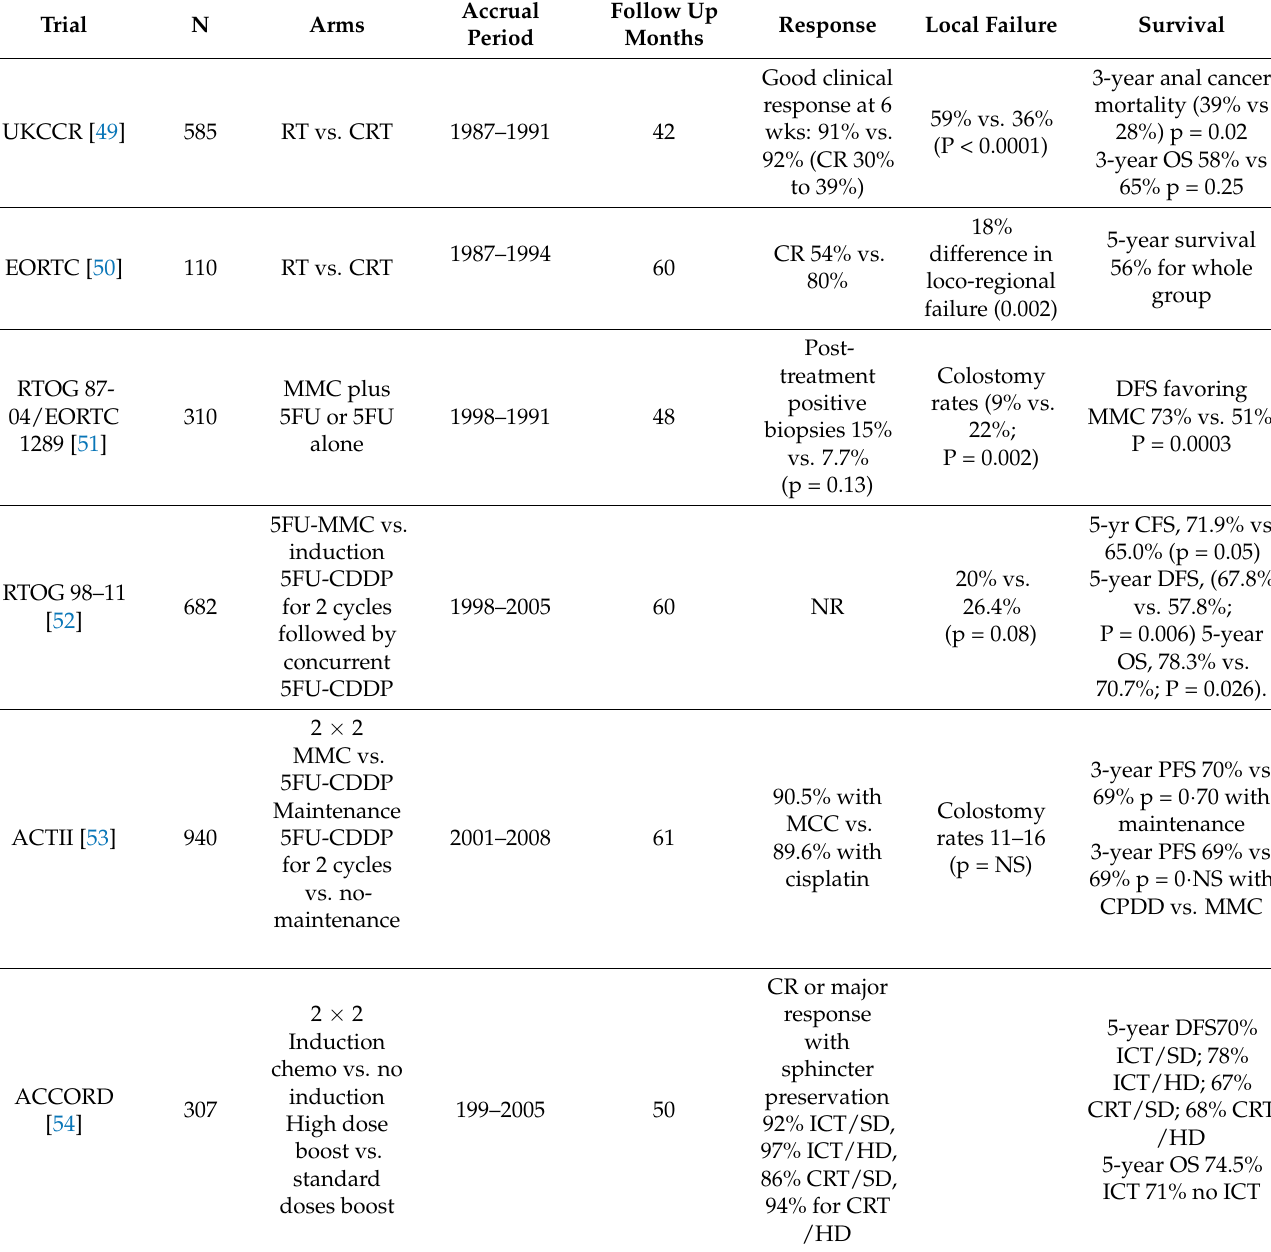
Table 3. Key phase 3 trials evaluated radiation versus chemoradiation therapy, induction or mainte- nance chemotherapy, or high or standard dose booster radiation therapy in patients with stage 1–3 and all canal